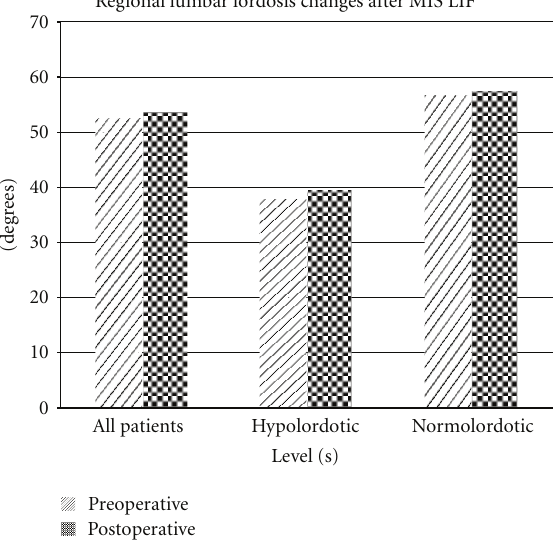
Figure 4: : Regional lumbar lordosis changes after MIS LIF. No statistically significant increases were observed.